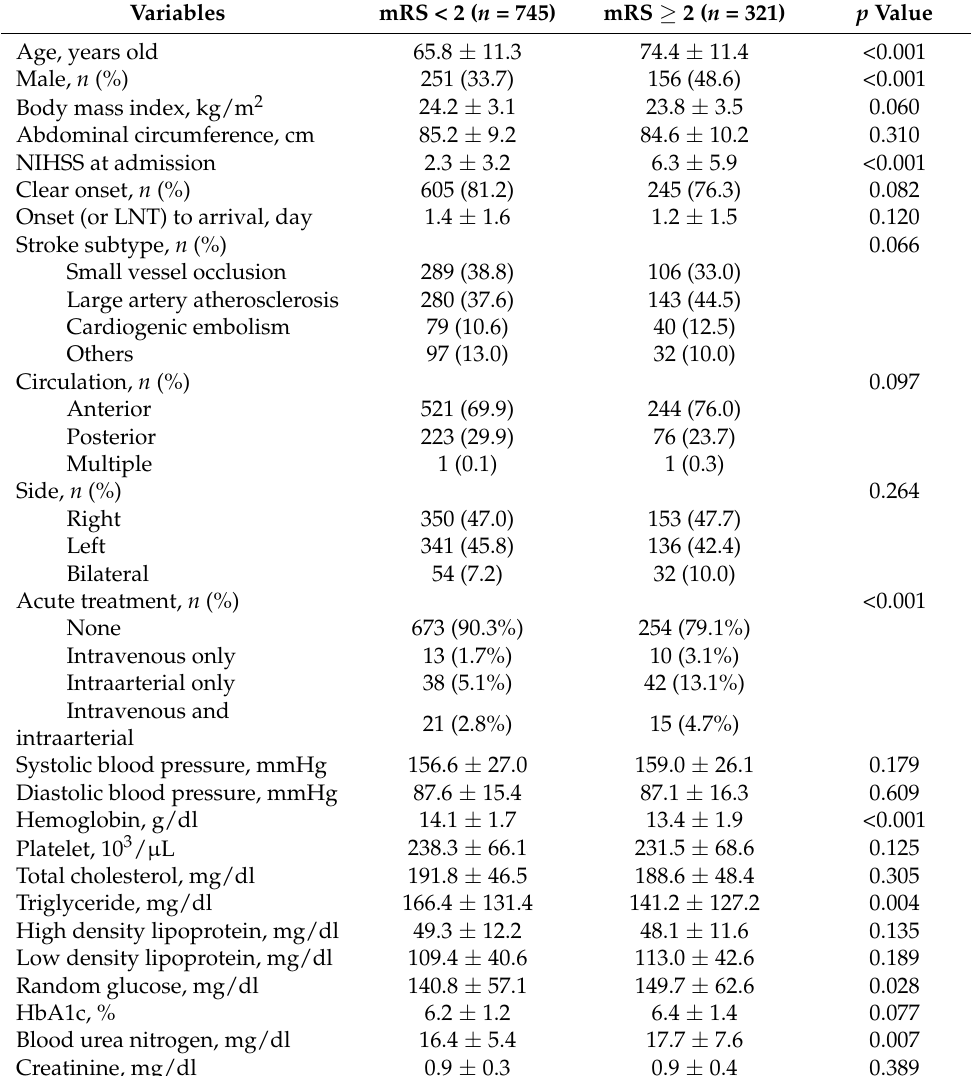
Table 1. Baseline characteristics and stroke-related factors in each group.